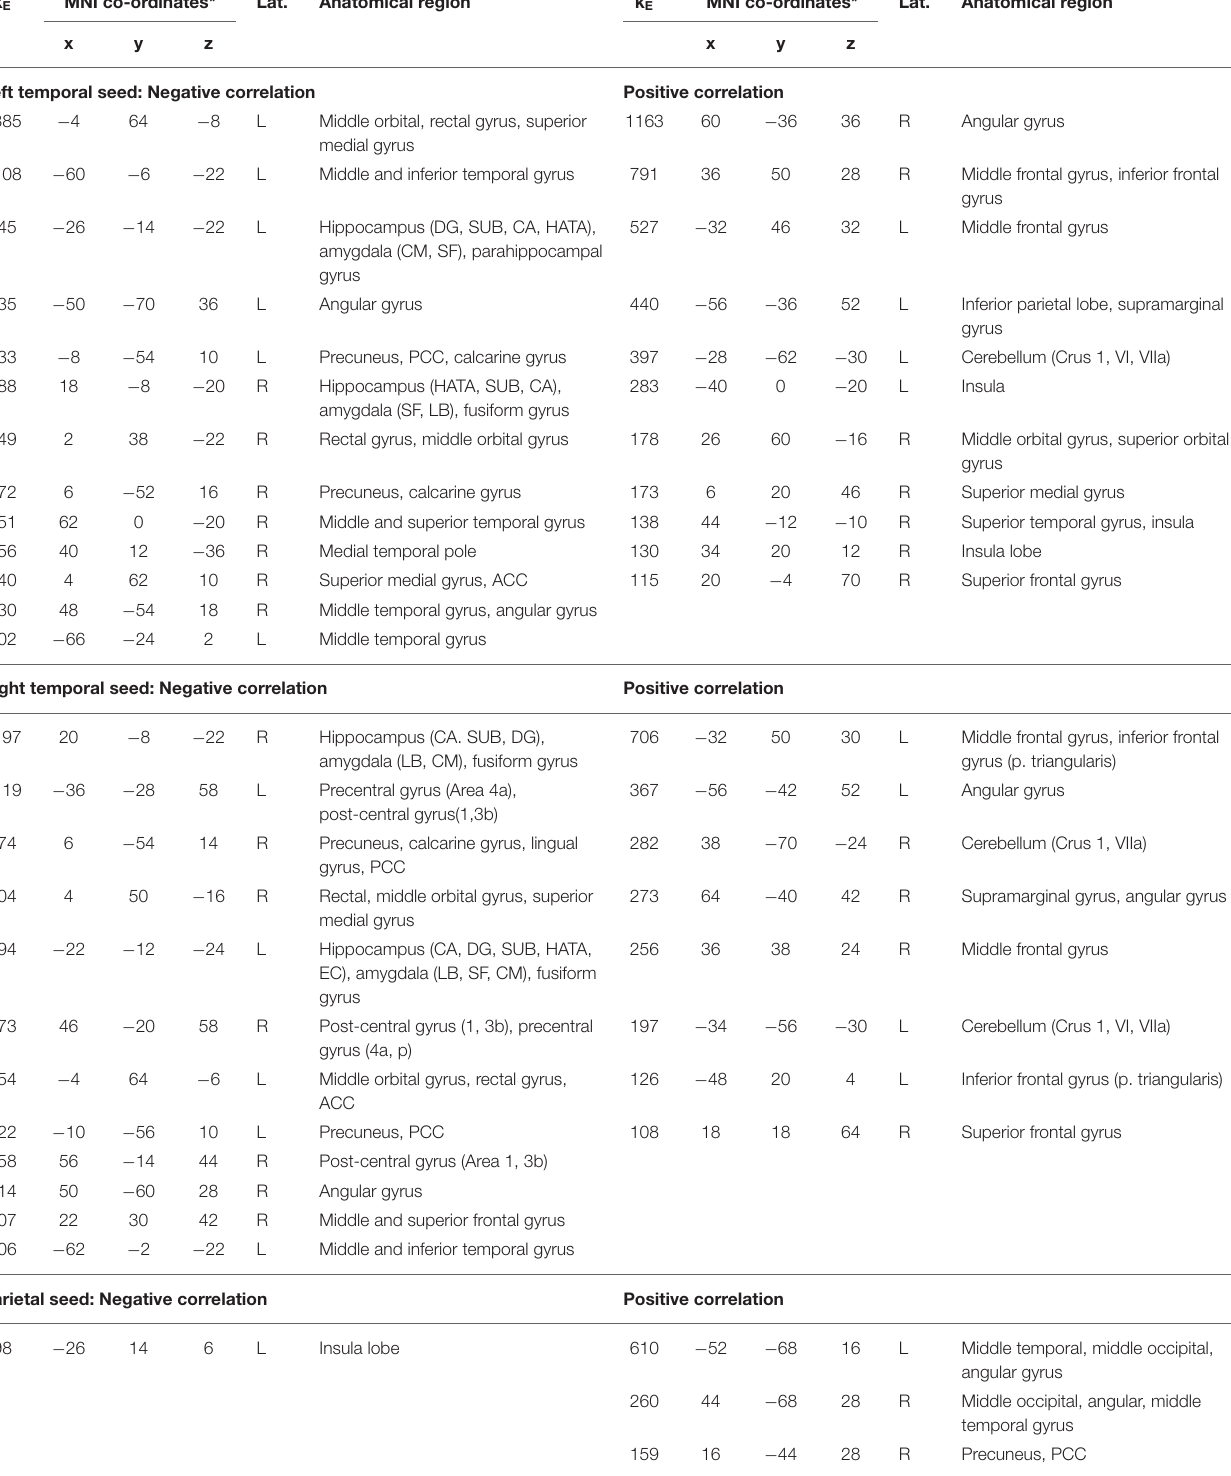
TABLE 3 | Resting-state fMRI connectivity correlations with age. k E MNI co-ordinates* Lat. Anatomical region k E MNI co-ordinates* Lat. Anatomical